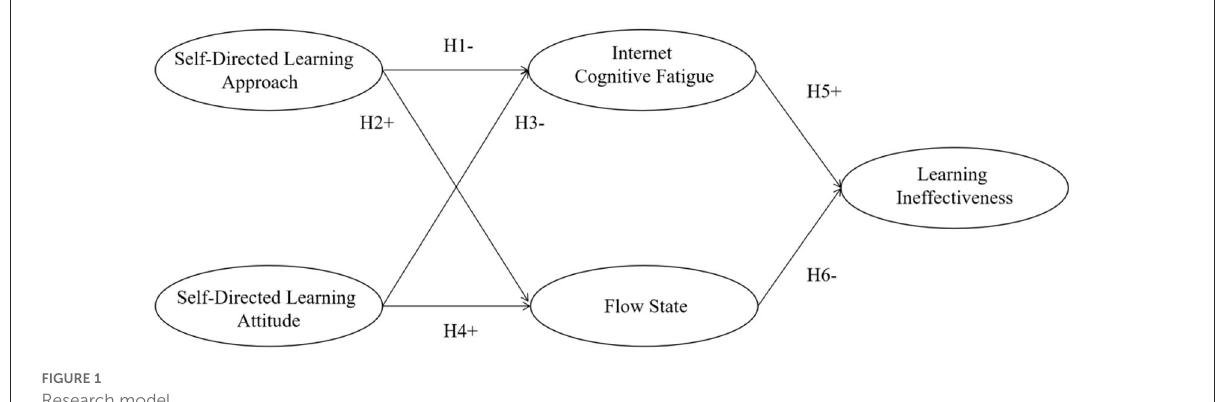
FIGURE1 Research